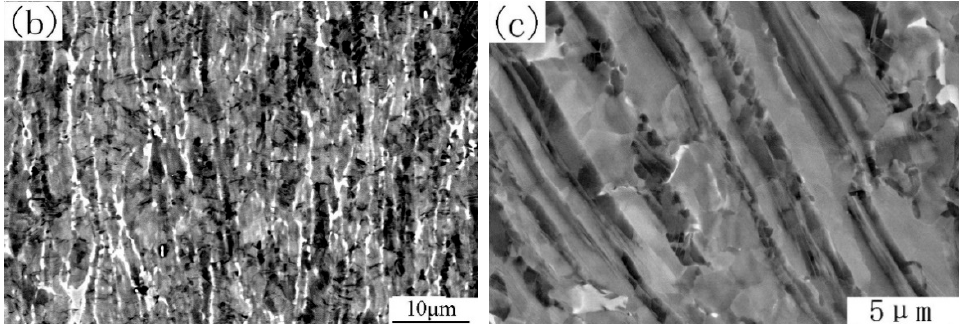
Figure 10. Microstructure of FJ: ( a ) microstructure evolution from PM to SDZ; ( b ) SDZ; ( c ) recrystallization in remnant LCc.